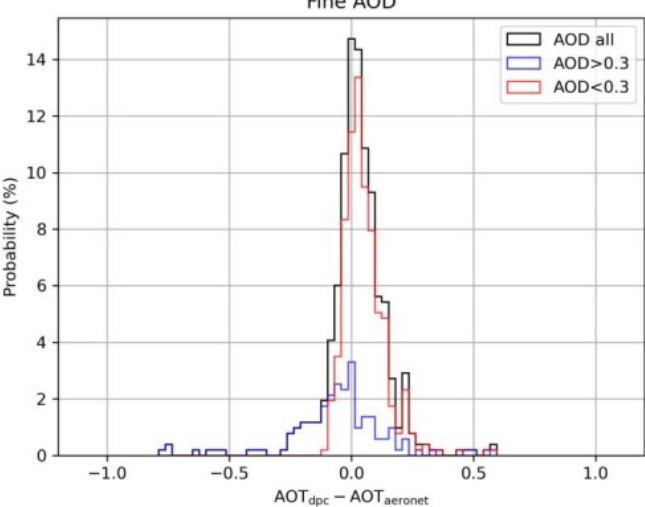
Figure 5. Same as Figure 2 but for the fine mode AOD.